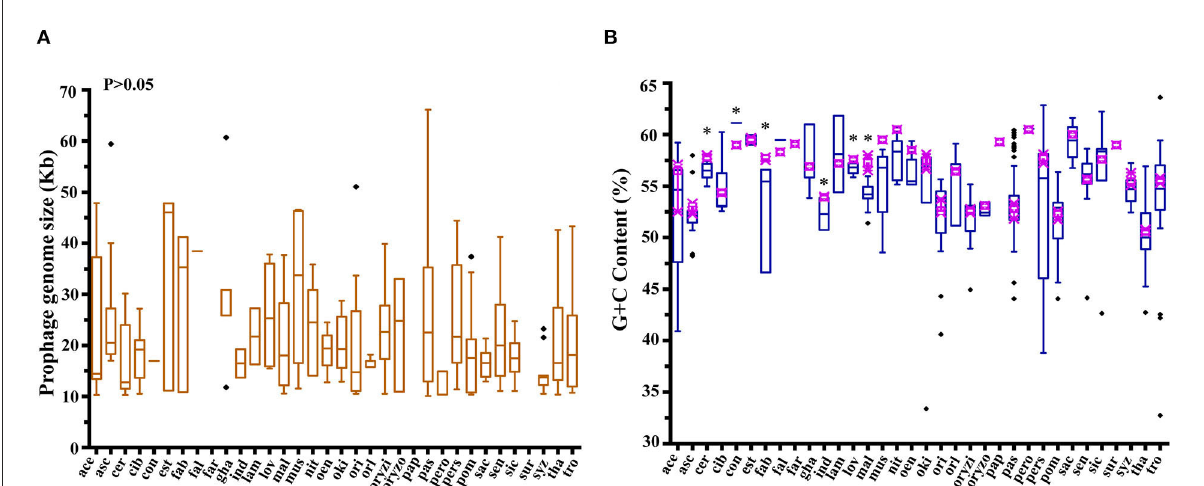
FIGURE2 Characterization of 350 active prophage genomes. (A) Comparison of prophage genome size. A non-parametric test (Kruskal–Wallis) using multiple independent samples was performed. (B) Comparison of the GC content of the prophage genomes with their respective hosts. Blue boxes represent prophages and red boxes represent host strains. (cid:7) , outliers. Non-parametric Mann–Whitney U -test and two-tailed method were used to check p- values comparing prophages and hosts in each group, * p < 0.05.